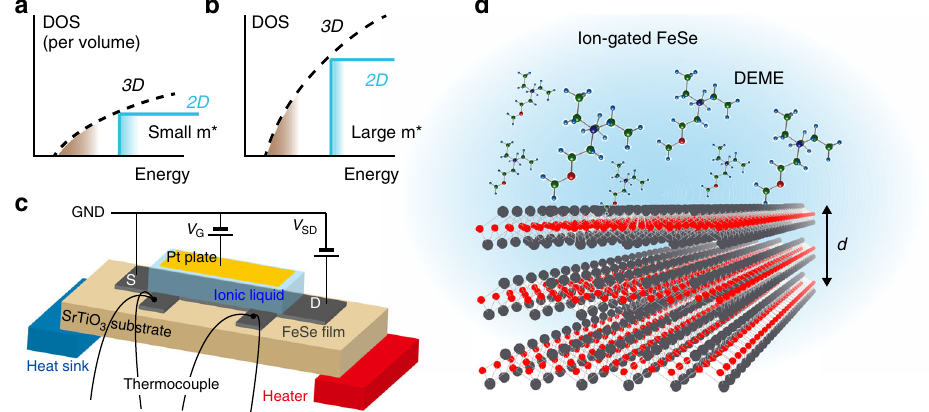
Fig. 1 Schematic device structure for thermoelectric measurement. a Schematic illustration of the electronic density of states (DOS) for three-dimensional (3D) and two-dimensional (2D) electrons. b The large effective mass m * enhances the DOS, which is favorable to the enhancement of the Seebeck effect. c Device structure for thermoelectric measurement. V SD and V G stand for the source (S) − drain (D) voltage and the gate bias voltage, respectively. When V G is applied to the Pt plate, ions in the ionic liquid are redistributed, forming an electric double layer on the surface of the FeSe of the ionic liquid/FeSe interface. Under the positive gate bias, N , N -diethyl- N -(2-methoxyethyl)- N -methylammonium cations, DEME + , align on the surface of FeSe. The thickness d of the FeSe thin fi lm was tuned by electrochemical etching 15 . See Methods for details of the device structure and